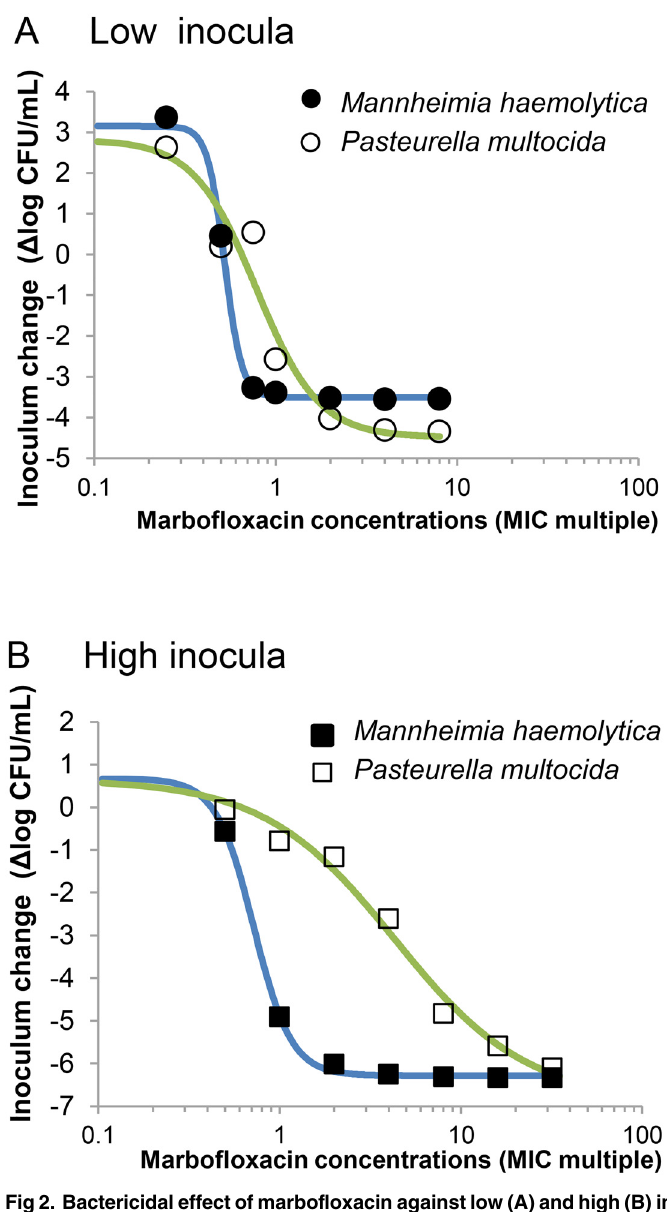
Fig 2. Bactericidal effect of marbofloxacin against low (A) and high (B) inocula of M . haemolytica (full symbols) and P . multocida (open symbols) isolates.